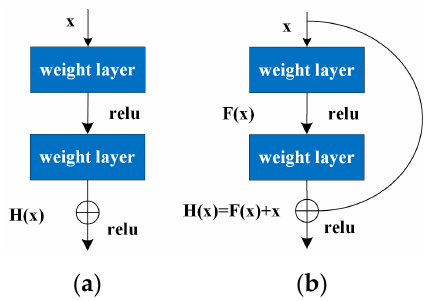
( b ) Figure 4. ( a ) Binary diagram of co ff ee machine and ke tt le. ( b ) Matrix heat map of co ff ee machine and ke tt le. 3. Identi fi cation Network Construction